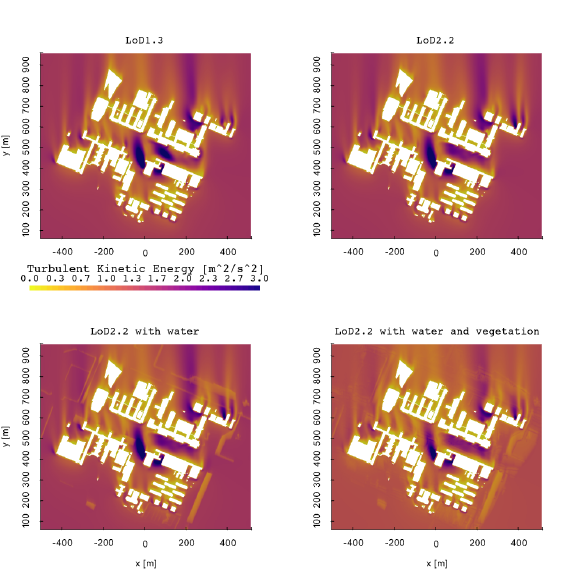
Figure 6. Turbulent kinetic energy for the four cases at pedestrian height (1.75